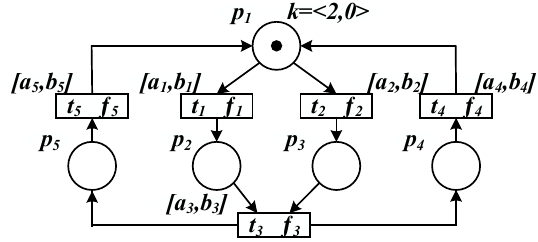
Figure 1. An example of PRES+ model.